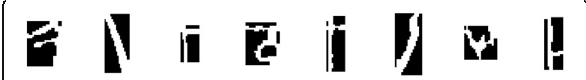
Fig. 3 ‘ Noise ’ segments passed to the OCR stage as characters